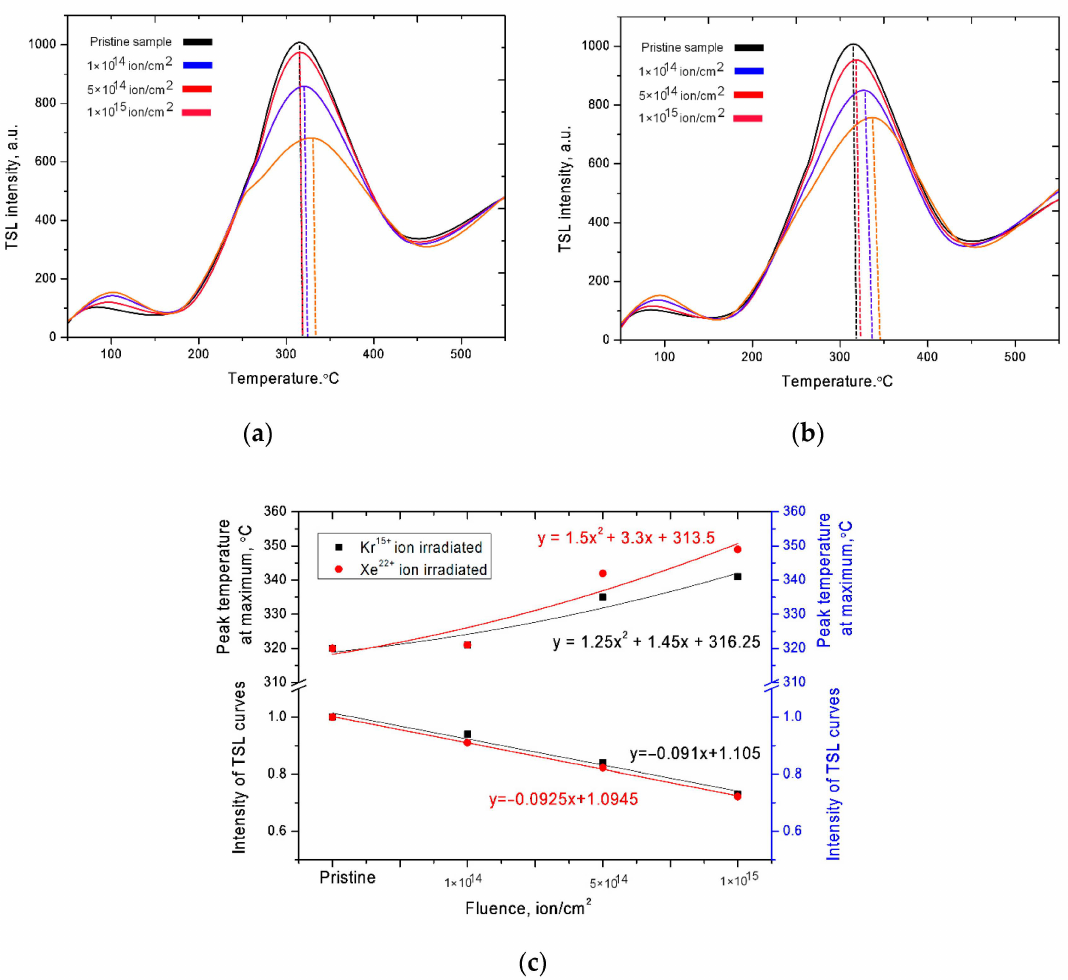
Figure 1. Thermally stimulated luminescence (TSL) curves of the studied ceramics depending on the heating temperature: ( a ) Kr 15 + ion irradiated dose; ( b ) Xe 22 + ion irradiated dose; ( c ) Graph of changes in the TSL curves’ intensity and maximum temperature depending on the irradiation